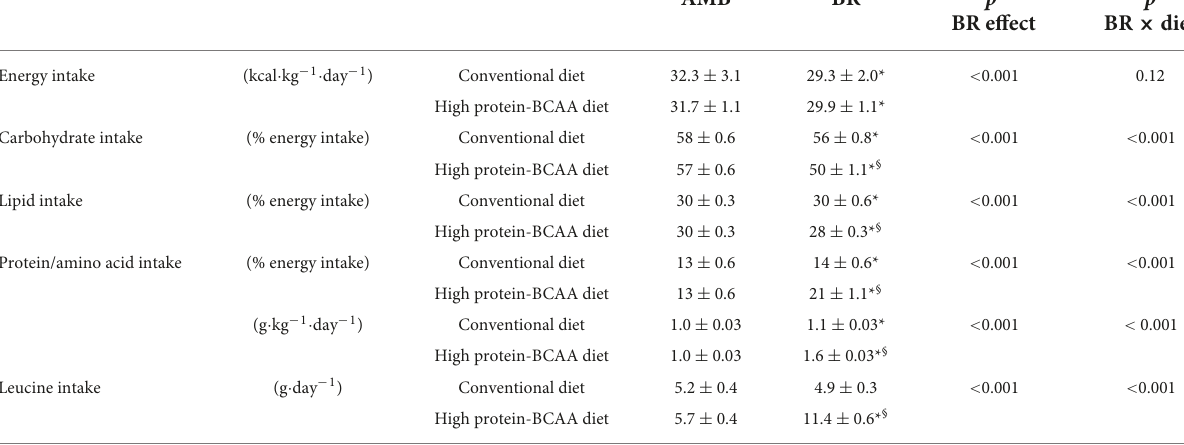
TABLE 1 Summary of dietary intake in ambulatory condition and during 60-days of bed